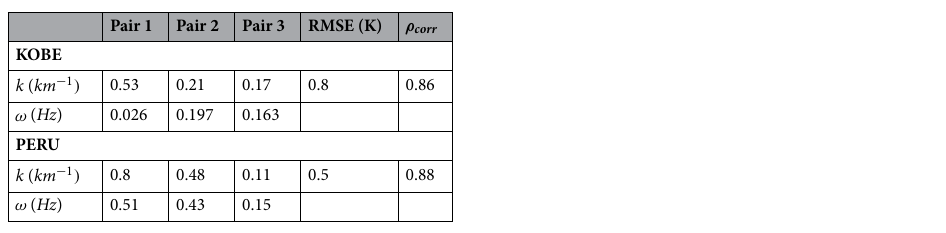
Table 2. Parameters ( k